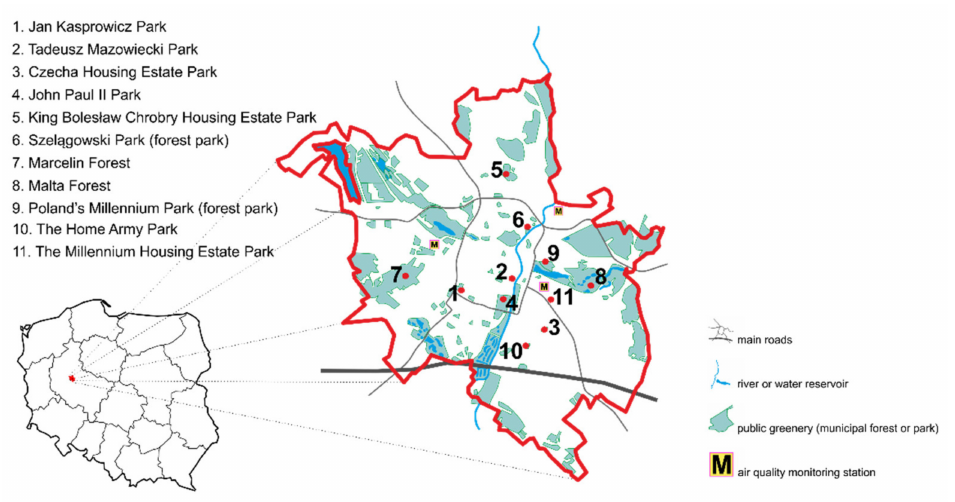
Figure 1. A map showing the location of the city of Poznan in Poland and the location of forests and parks under investigation. Table 1. Total number of the examined specimens in different places of investigation and the number of examined specimens of each of the investigated